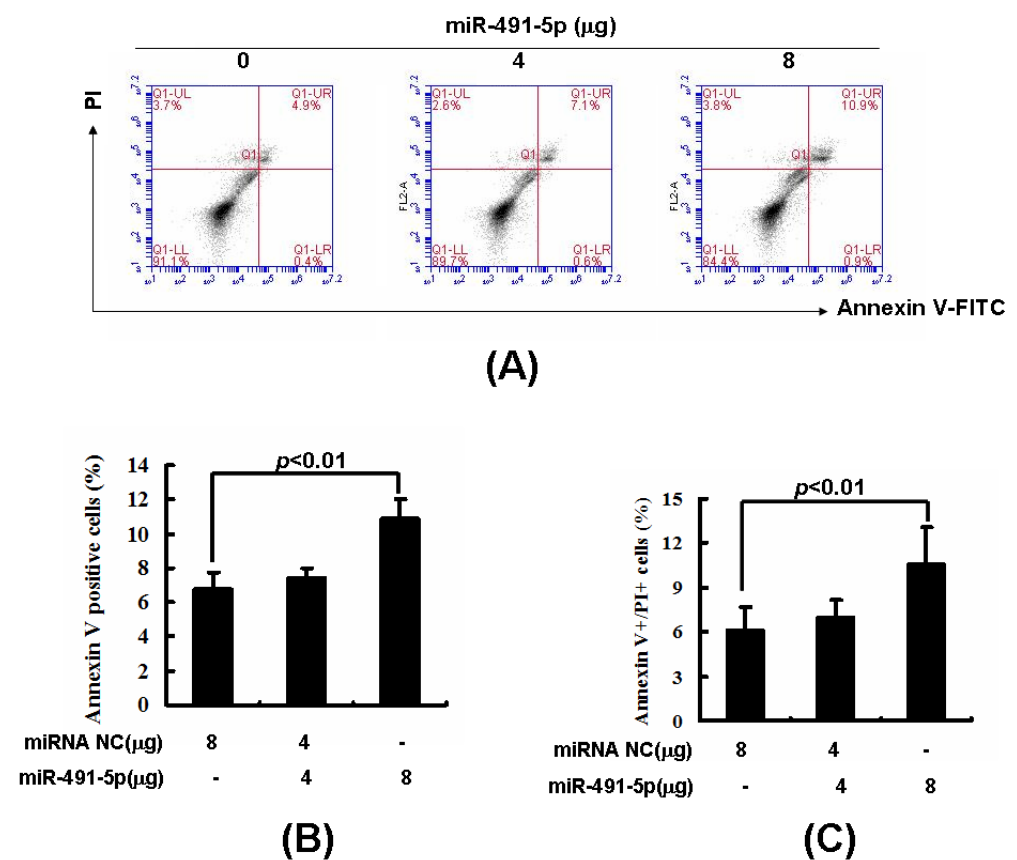
Figure 6. miR491-5p induced cell apoptosis in pancreastic cancer cell line SW1990. ( A ) The detection of cell apoptosis in miR491-5p transfected SW1990 cells was